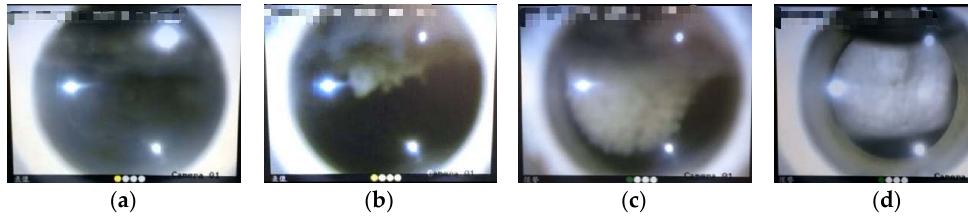
Figure 3. Macroscopic observation of CO 2 hydrate formation with GO at 279 K and 3.8 MPa, ( a ) the initial stage; ( b ) the nucleation stage; ( c ) the growth stage; ( d ) the final stage.